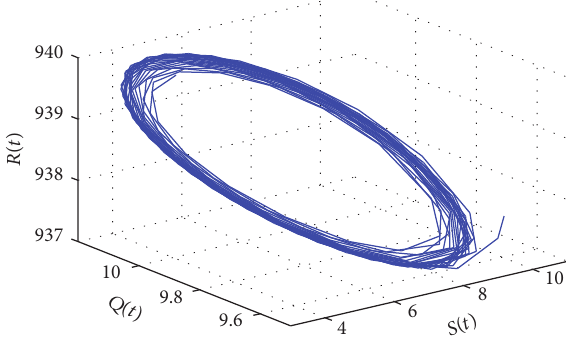
Figure 6: The phase plot of 𝑆 , 𝑄 , and 𝑅 when 𝜏 1 = 1.3625 > 1.3265 = 𝜏 10